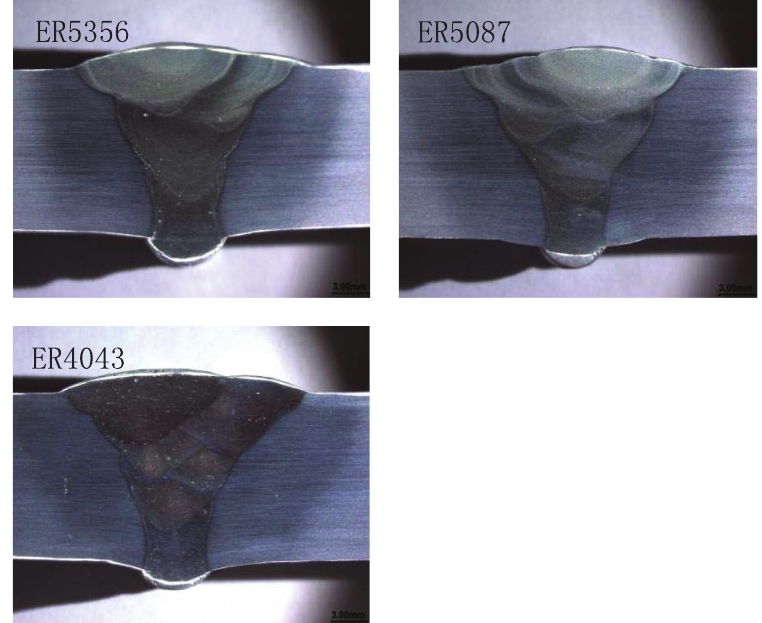
Figure 2: Macro morphologies of weld cross